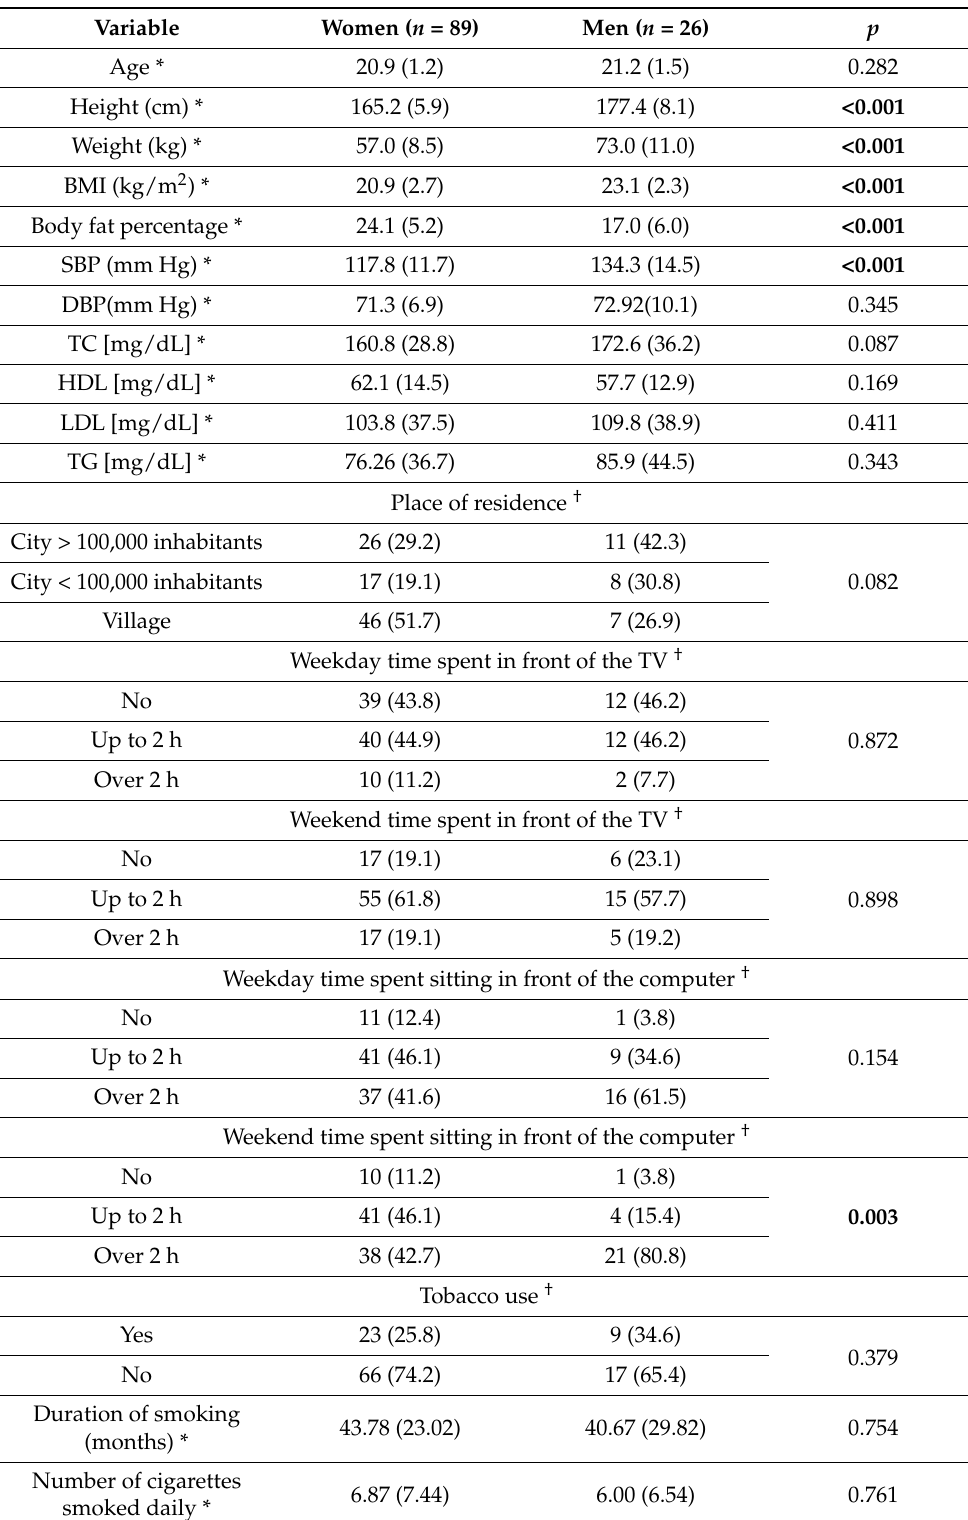
Table 1. Characteristics of the study